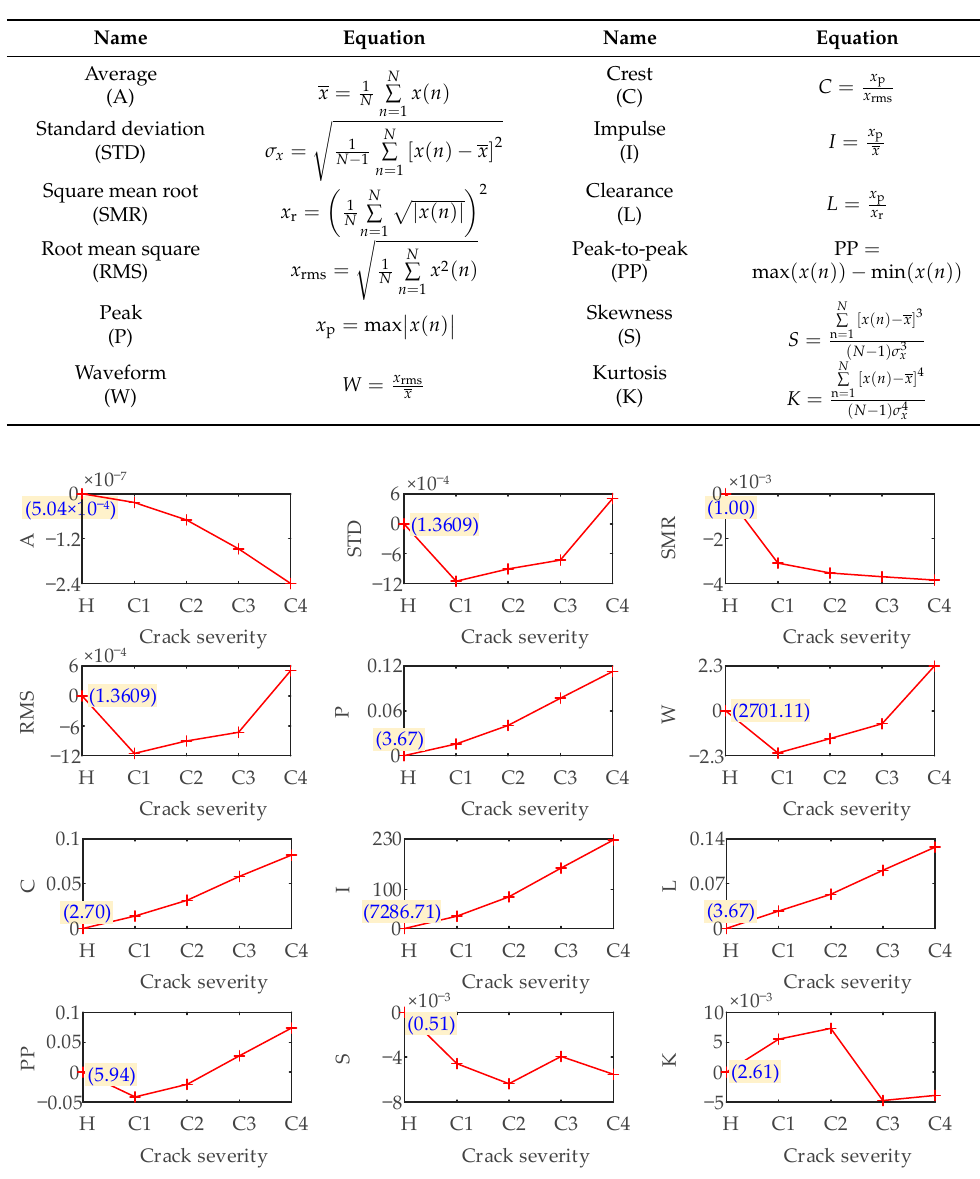
Figure 20. Fluctuations of time-domain indicators relative to the healthy condition for different crack degrees. Table 5. Time-domain statistical indicators.